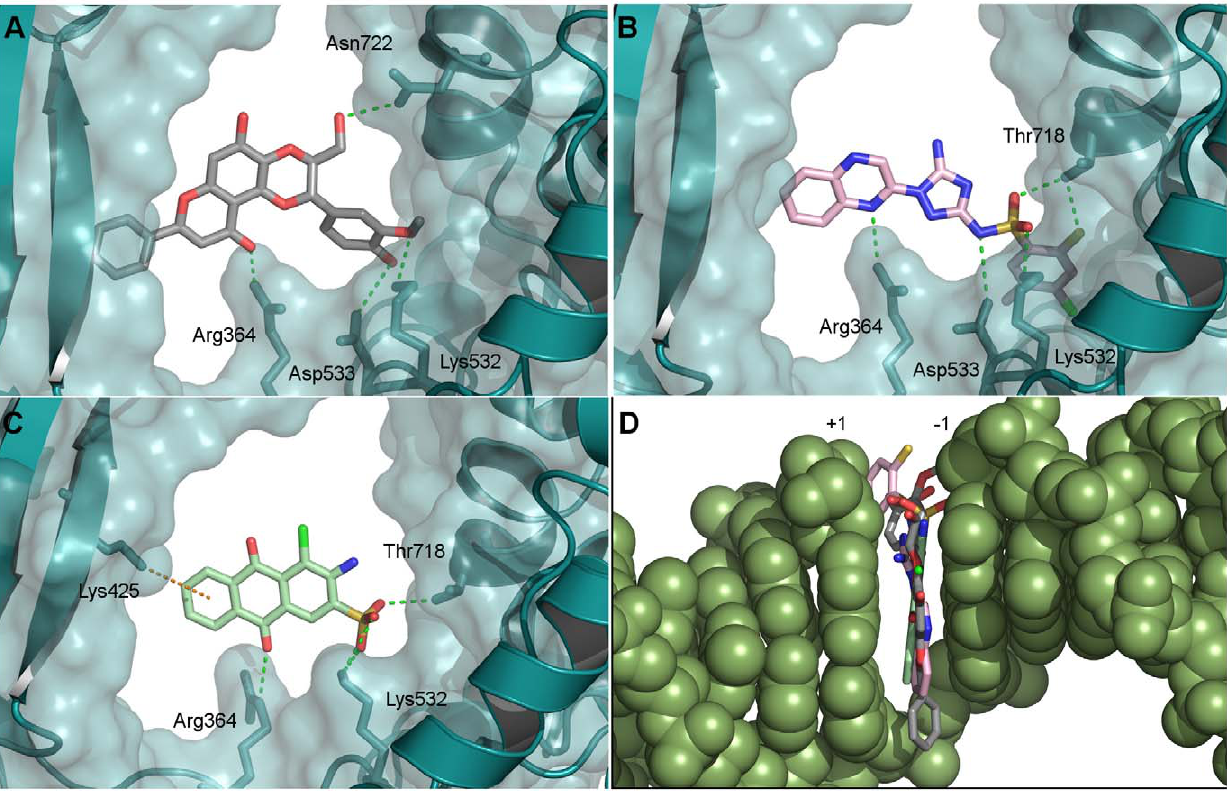
Figure 6. Docking results. Interactions between protein side chains and docked ligand: (A) Scutellaprostin G, (B) NSC 0674004, (C) NSC 0039875. (D) Overlay of docking poses of Scutellaprostin G (gray carbons), NSC 0674004 (pink carbons) and NSC 0039875 (green carbons) within the DNA cleavage site. See Figure 3 for details of representation and colours.